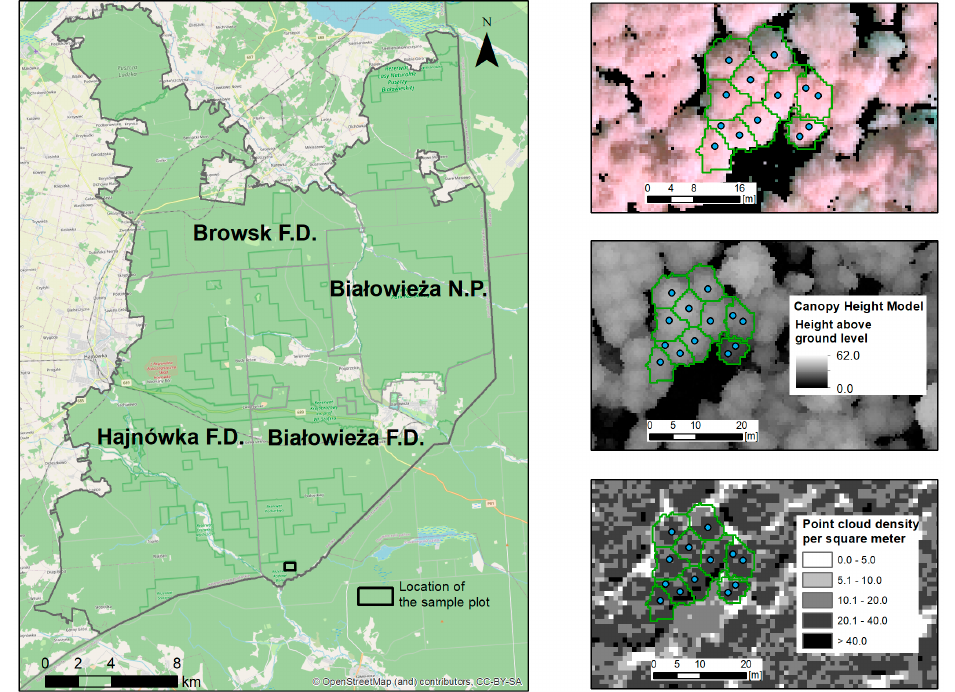
Figure 1. Polish part of the Bia ł owie ż a Forest. In addition, data samples for one monitoring plot are presented. From top to bottom: a rasterised point cloud with RGB values, canopy height model, and point cloud density. The polygons represent the results of individual tree detection, while the points represent the locations of the trees measured in the field.